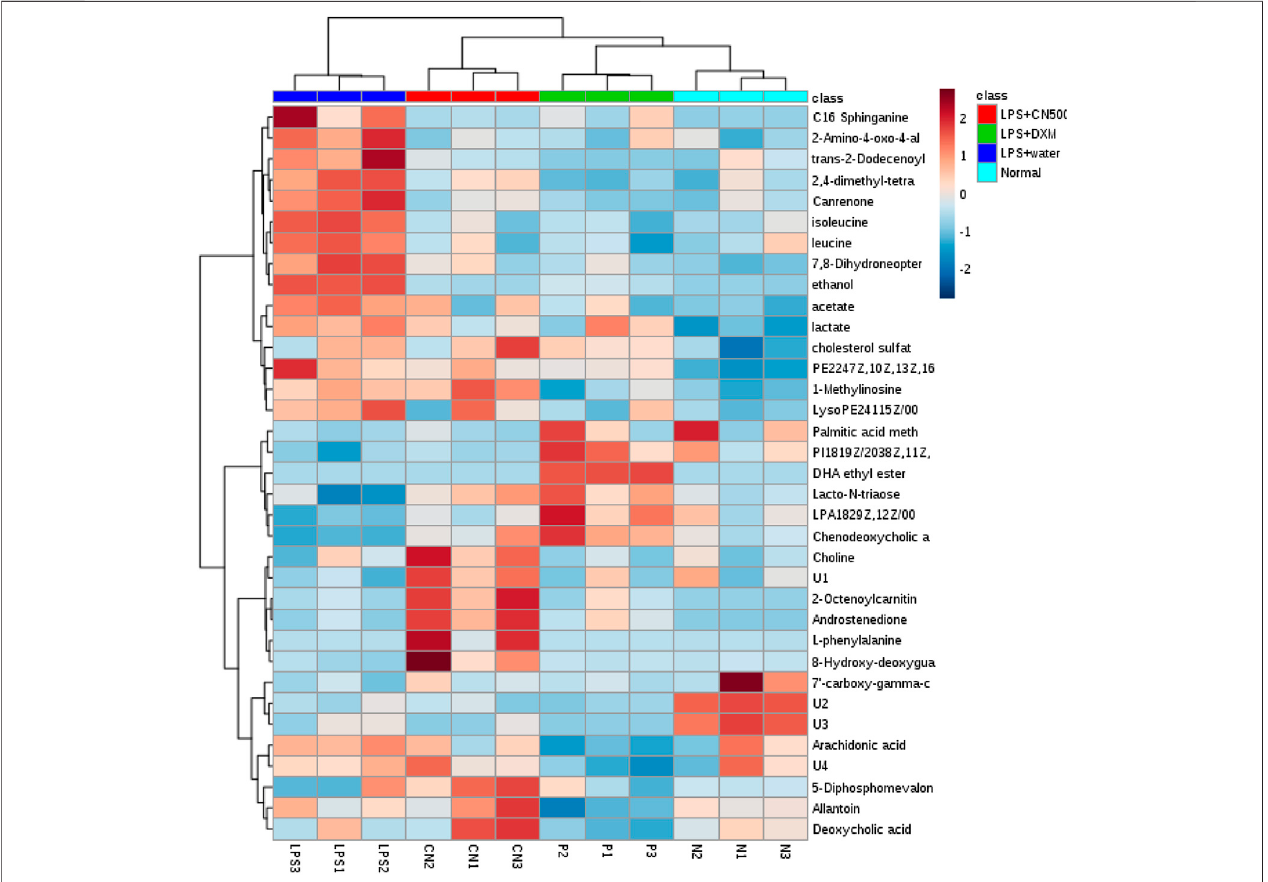
FIGURE 4 | Heat map of the 37 biomarkers in normal, LPS-induced, LPS+500CN, and LPS + DXM rats sera based on HCA using Euclidean distance and Ward ’ s minimum variance method. The concentration of each metabolite is coloured based on a normalized scale of minimum − 2 (dark blue) to a maximum of 2 (dark red).